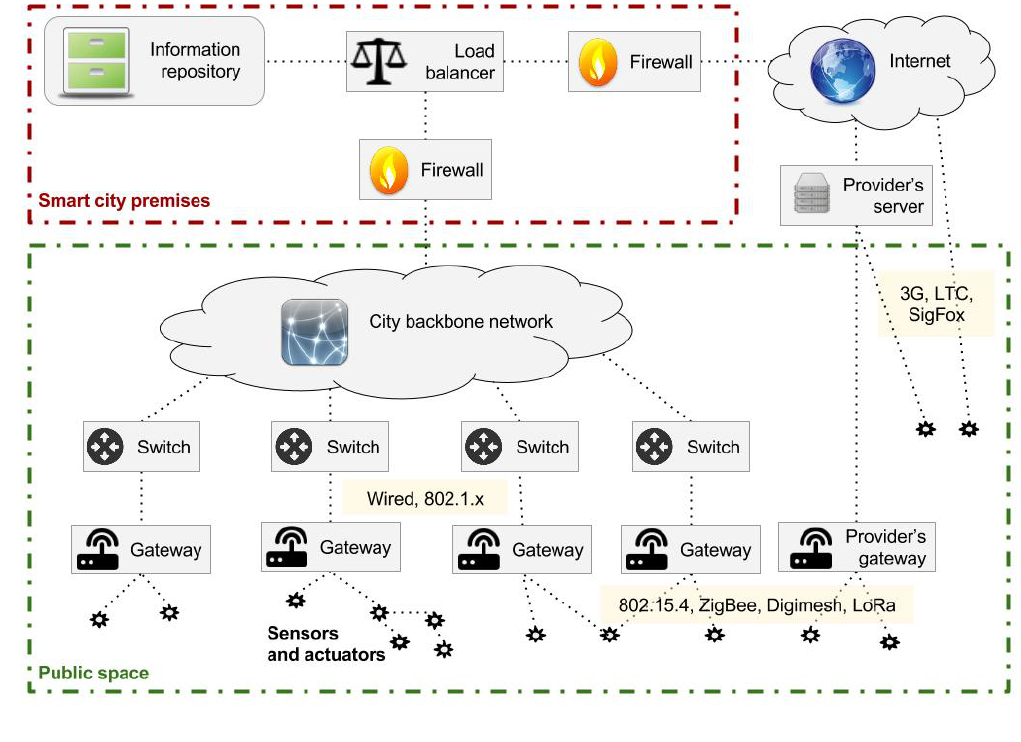
Figure 1. WSN data collection